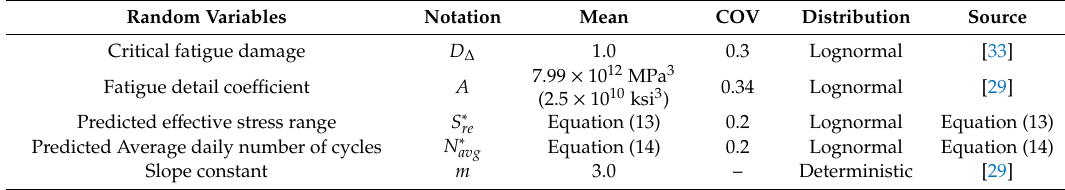
Table 5. Random variables for fatigue reliability evaluation of